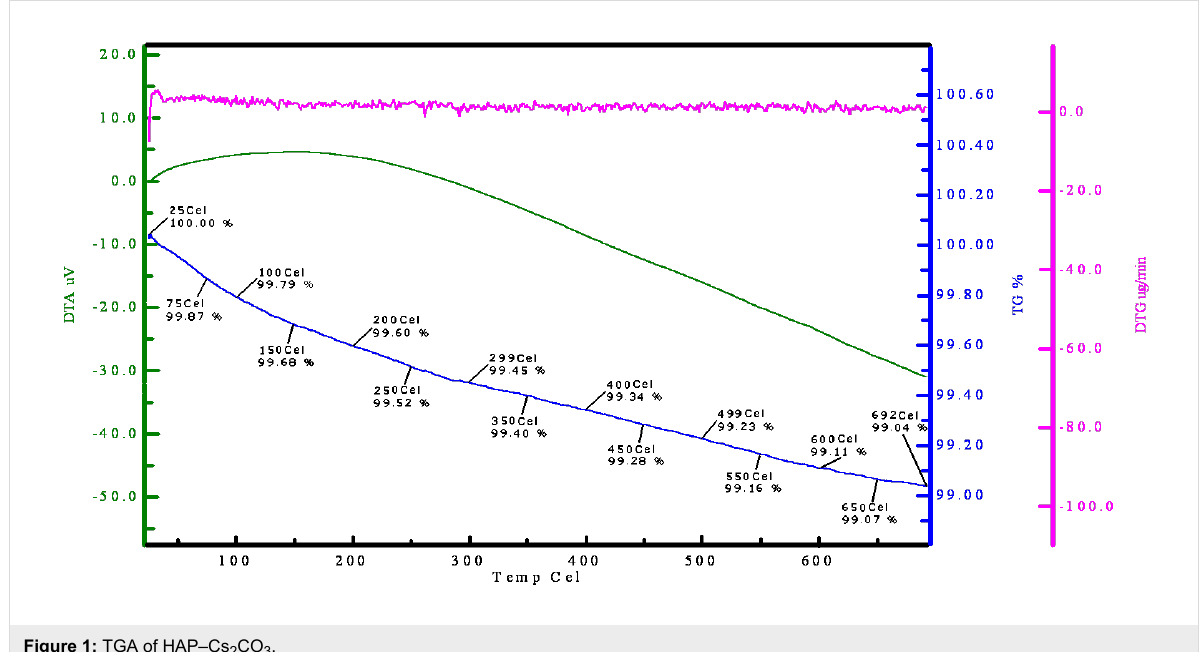
Figure 1: TGA of HAP–Cs 2 CO 3